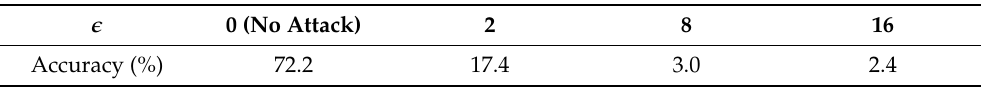
Table 11. Various (cid:101) values used in the experiments and the average classification accuracy of attacked images in each (cid:101) .